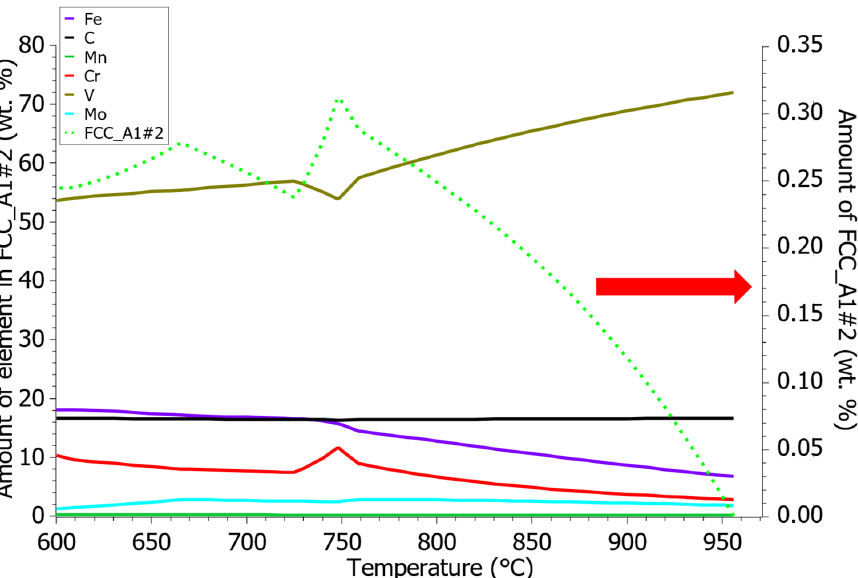
Figure 3. The equilibrium chemical composition of vanadium carbides (FCC_A1#2) and amount of precipitated FCC_A1#2 carbides (doted curve – right axis marked by red arrow) during cooling.